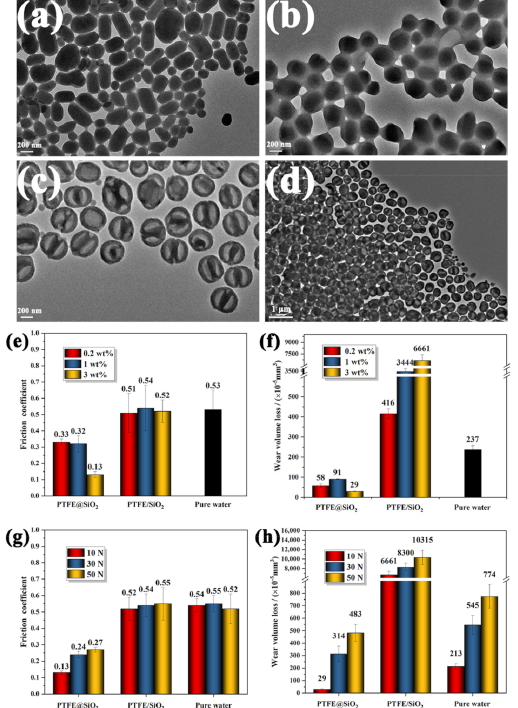
Figure 17. TEM and SEM images of pure PTFE ( a ), PTFE@P(MMA–co–MPS) ( b ), and PTFE@SiO 2 ( c ) high magnification, ( d ) low magnification). The changes of friction coefficient ( e , g ) and wear volume loss ( f , h ) for the samples with different amounts of addition and load, respectively. The error bar represents the standard deviation of the average value of three tests. Reproduced from [116] with permission from the